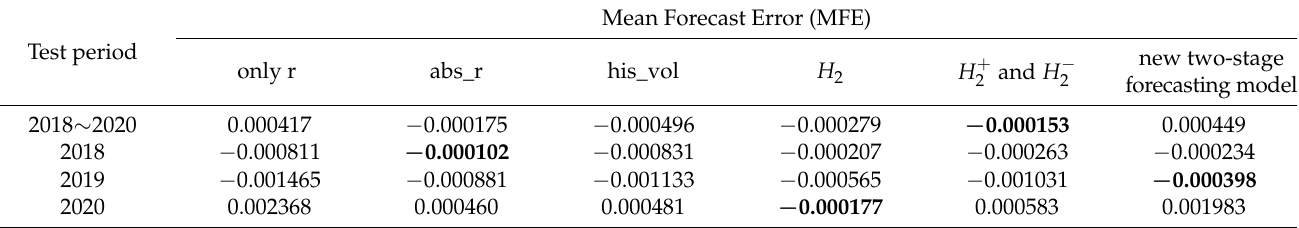
Table 6. Forecasting performance by period with new two-stage model (Please note that the best results are highlighted in BOLD